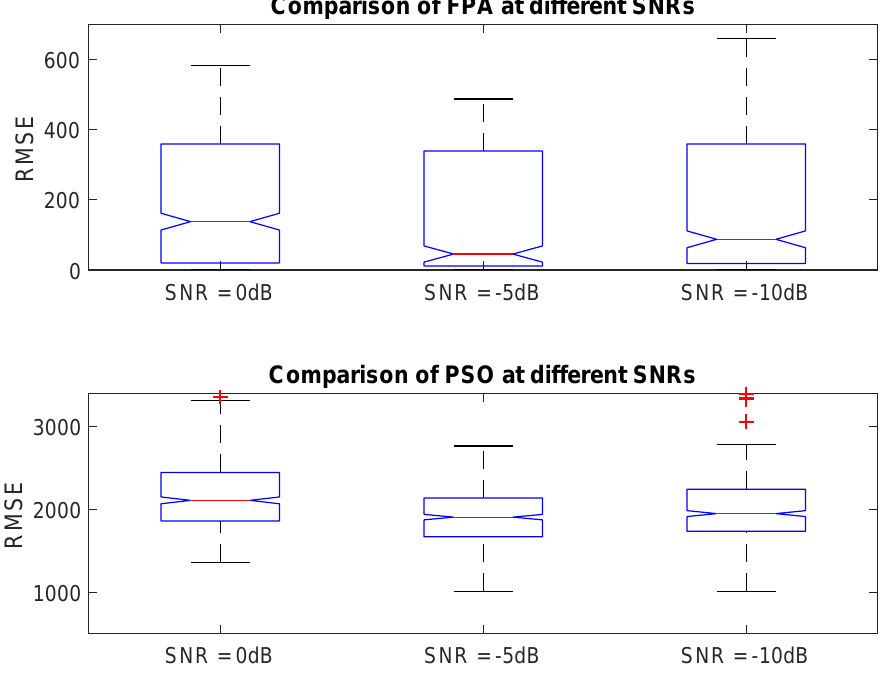
Figure 11. Variation analysis of RMSE for nine targets.